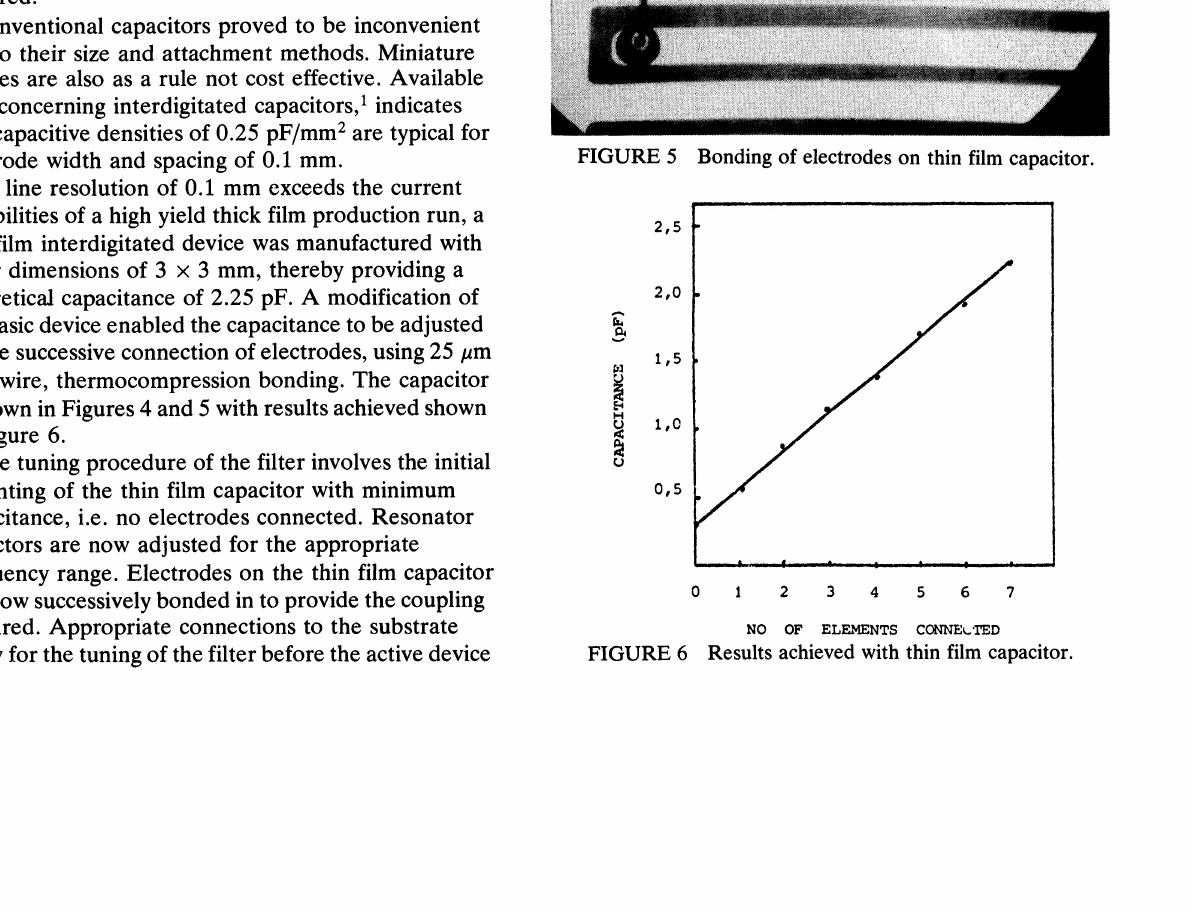
FIGURE 4 Details of thin film capacitor.